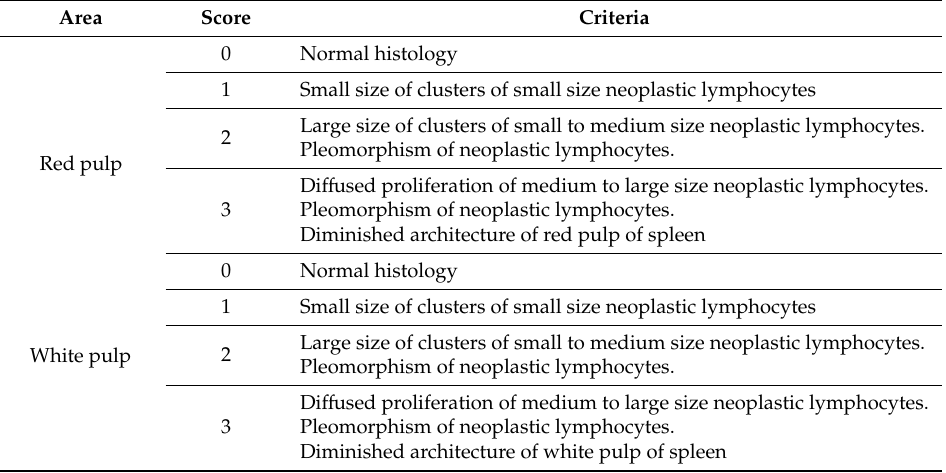
Table 6. Histopathological lesion scoring in the spleen of leukaemia-bearing